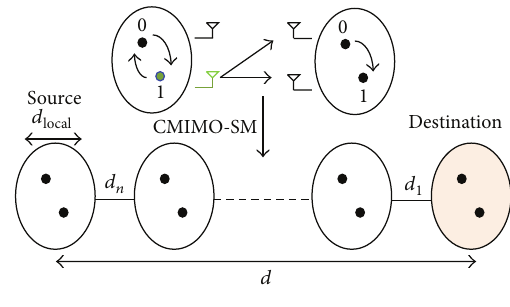
Figure 9: The structure of multihop CMIMO-SM.